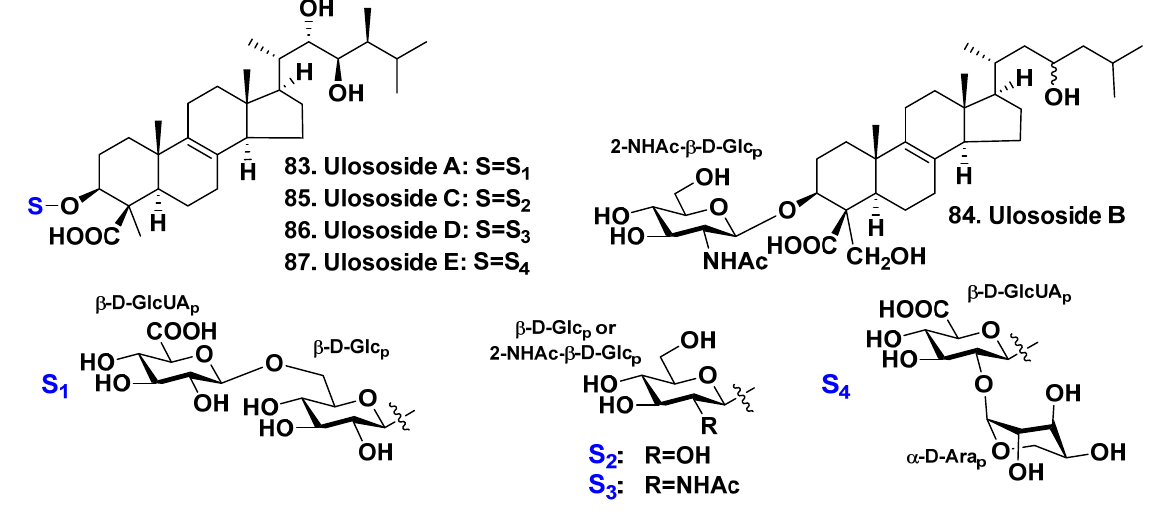
Figure 10. Ulososides 83 – 87 from Ulosa